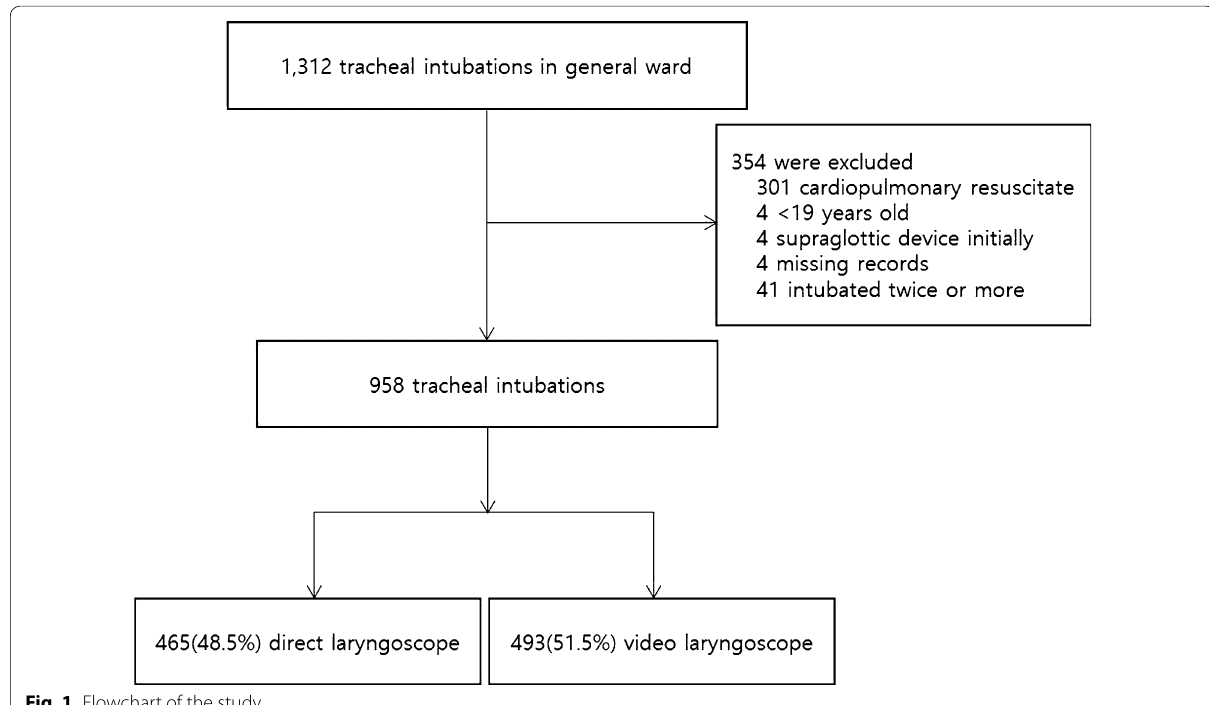
Fig. 1 Flowchart of the